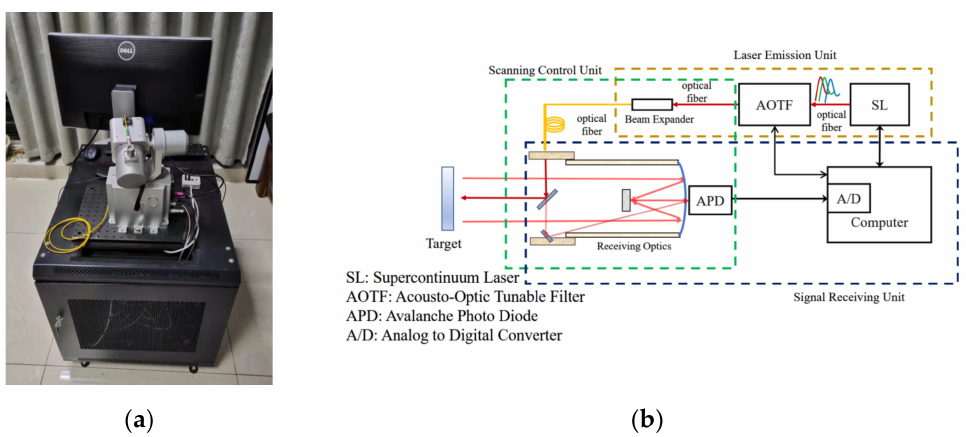
Figure 1. Schematic of the HSL system: ( a ) installation and ( b ) system schematic; The red arrow represents the optical signal, while the black arrow represents the electrical